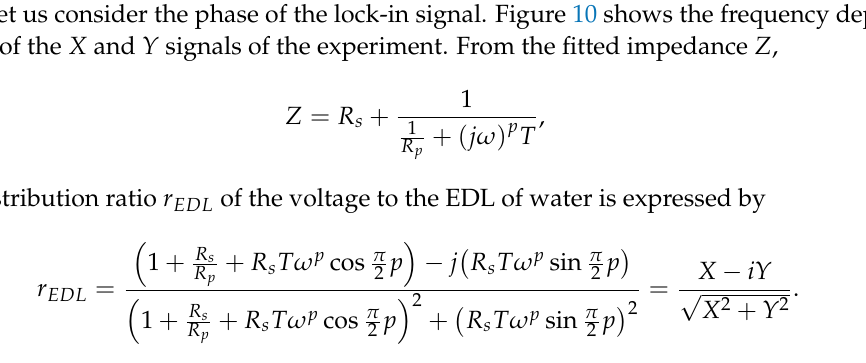
Figure 9. ( a ) Cole–Cole plot ( − Im 𝑍 against Re 𝑍 ). The green circle shows the impedance at 224 Hz, closest to 222 Hz. ( b ) Equivalent circuit assumed for the electrolyte bulk solution and the electric double layer (EDL).